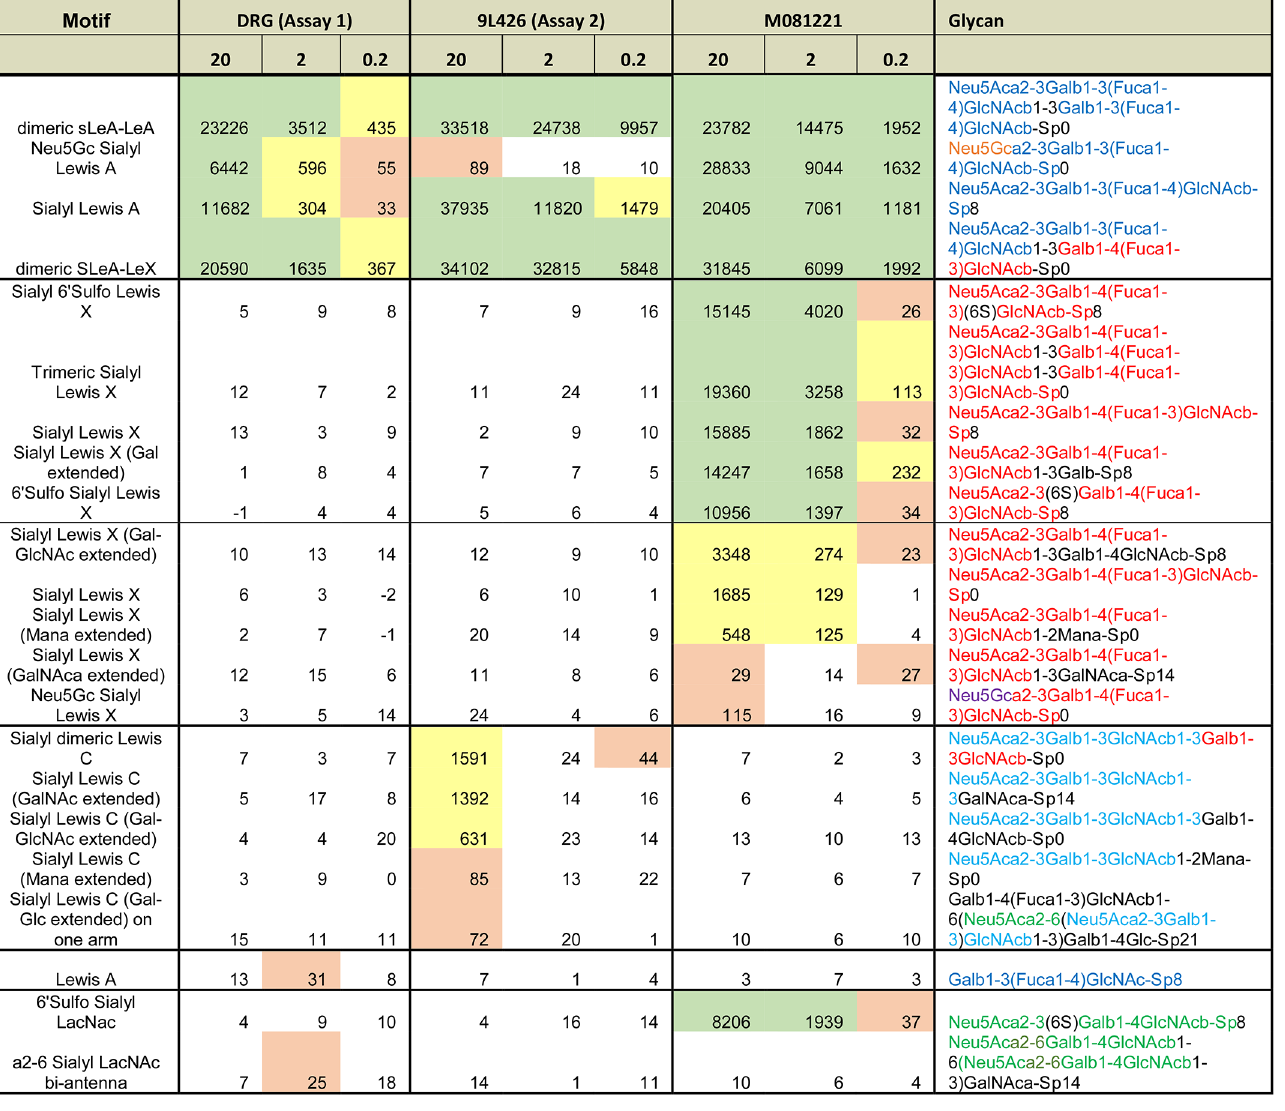
Fig 4. Glycan motifs recognized by three CA 19 – 9 antibodies. For each antibody, the binding intensity to the indicated glycans, in relative fluorescence units, is given at three antibody concentrations (in μ g/mL). Green indicates strong binding, yellow is moderate binding, and pink is weak